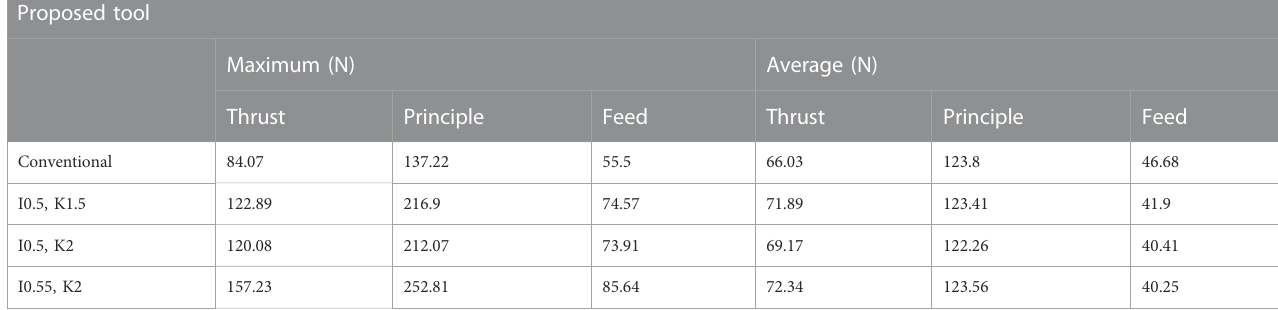
TABLE 4 Summary of cutting force results.